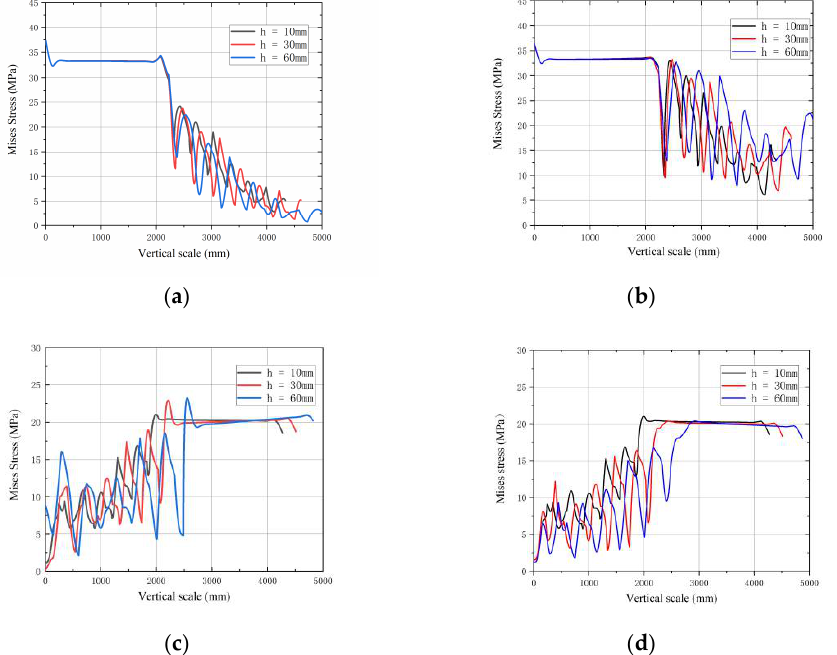
Figure 13. Mises stresses along the inner and outer steel pipe . ( a ) Compression side of the inner pipe. ( b ) Tension side of the inner pipe. ( c ) Compression side of the outer pipe. ( d ) Tension side of the outer pipe.